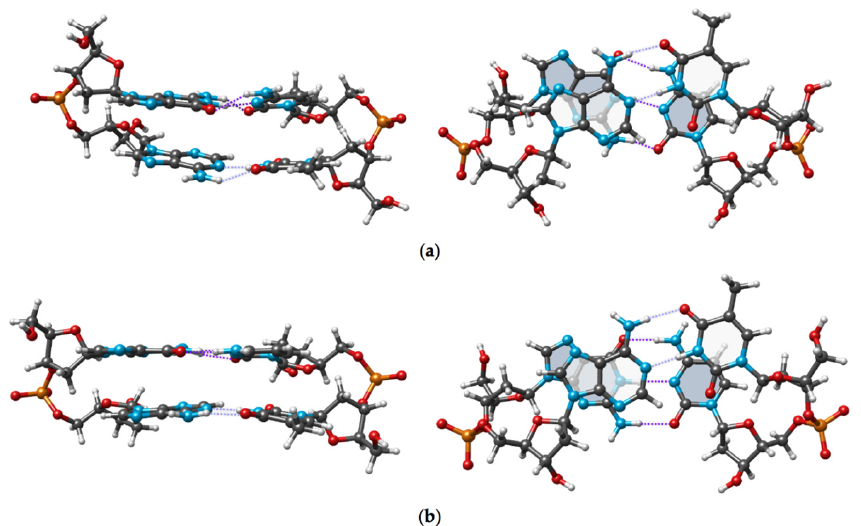
Figure 4. Experimental and optimized conformations of dGpdA:dTpdC. Both chains correspond to BB12 NtC. Two projections illustrate the nearly parallel arrangement of H-bonded base pairs and substantial superposition of purine base rings. ( a ) Experimental structure (NDB ID: NA0318); ( b ) The structure optimized by using the M05-2X functional.